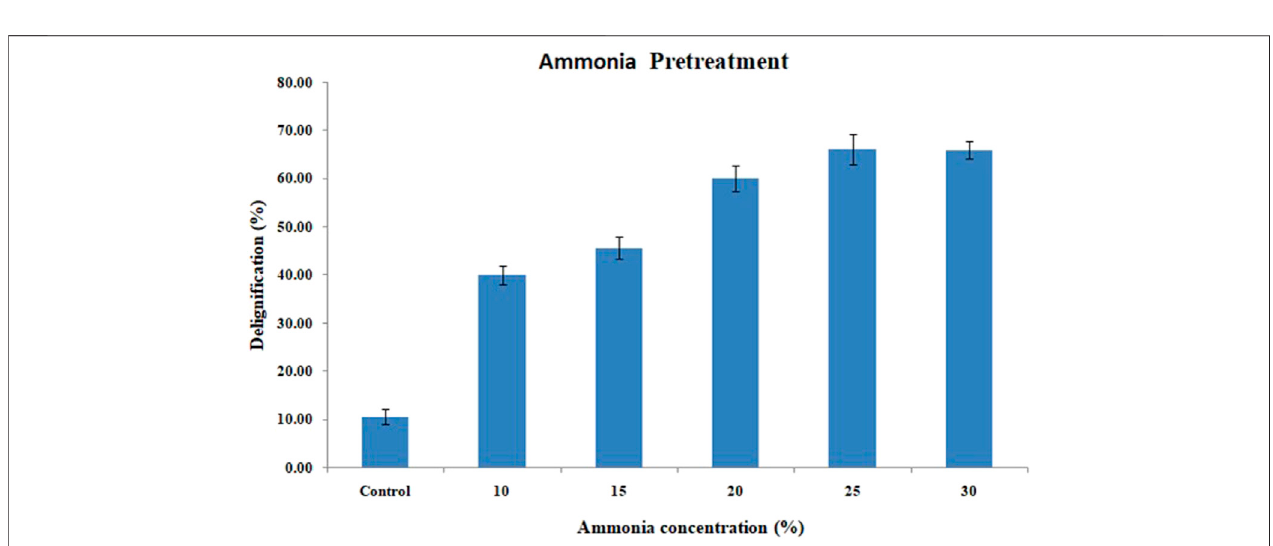
FIGURE 2 | Effect of different concentrations of aqueous ammonia on deligni fi cation of the corn cob residue.